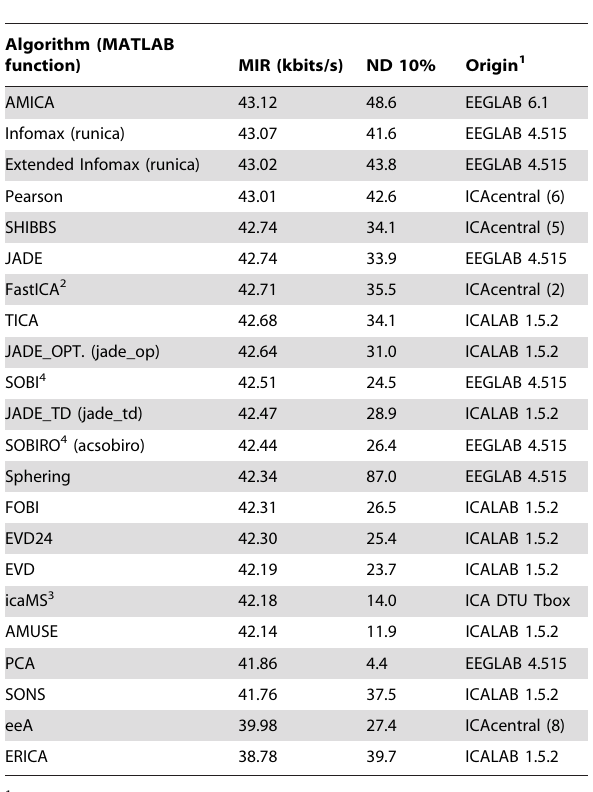
Algorithm (MATLAB function)